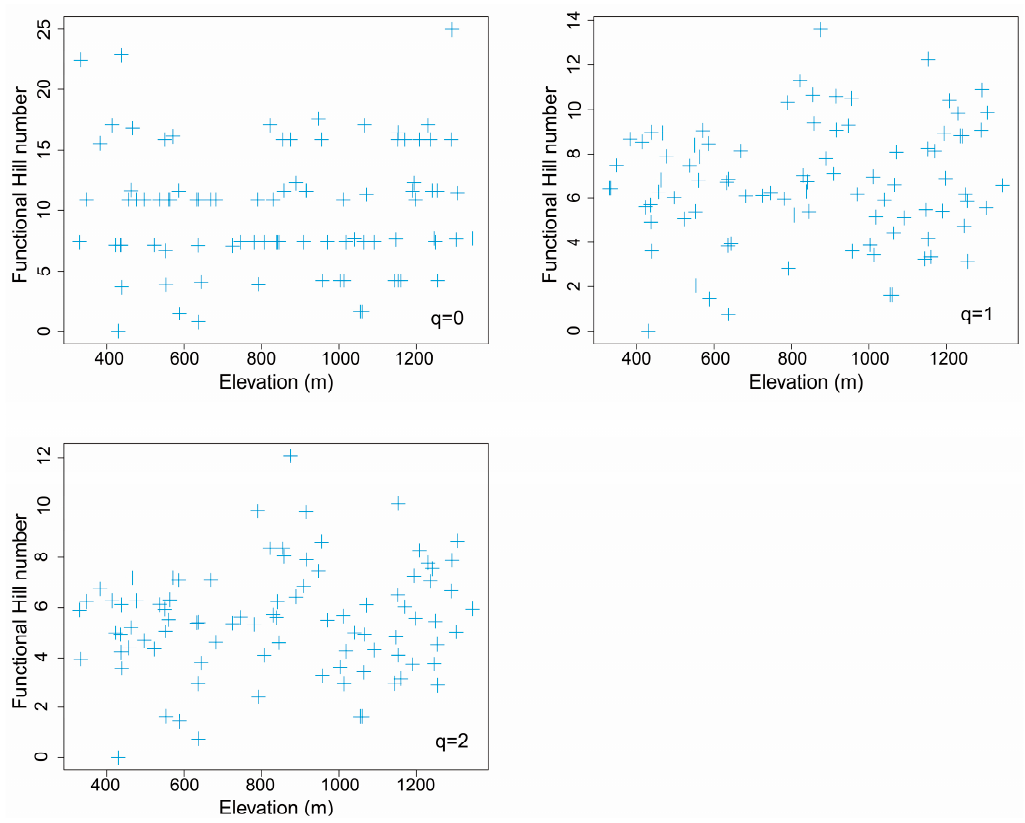
Figure 6. The elevational pattern of different total functional diversity indices for leaf mines on Quercus variabilis Blume.